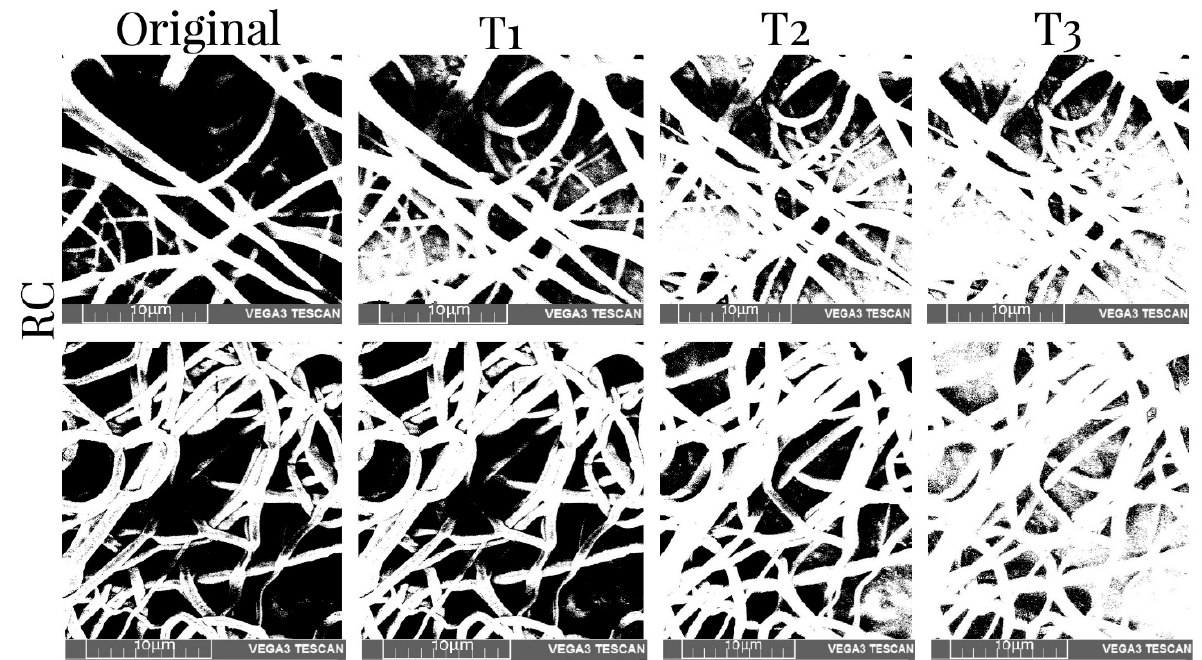
Figure 7. SEM images of the obtained XYP45 scaffolds and binary images with three thresholds before (top row) and after mechanical tests (bottom row). T1–T3: threshold 1–3.